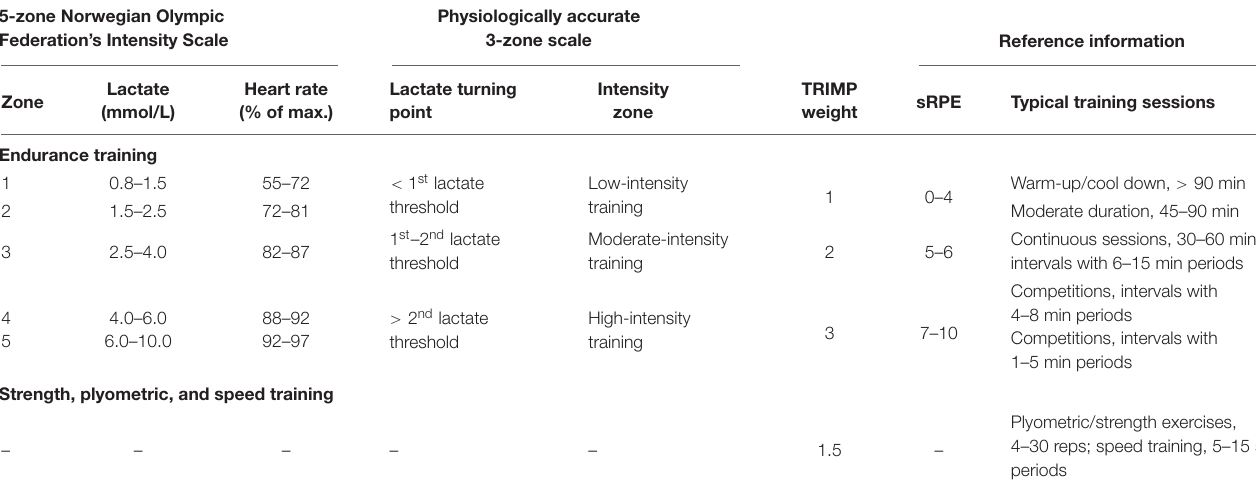
TABLE 2 | The intensity scale used to determine the training load of endurance and strength, plyometric, and speed training in this study. 5-zone Norwegian Olympic Physiologically accurate Federation’s Intensity Scale 3-zone scale Reference information